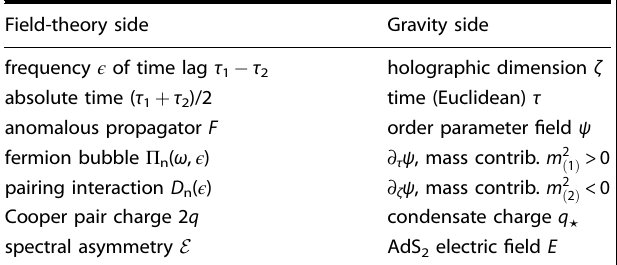
Table 1. Dictionary of the Eliashberg-gravity map. Summary of the correspondence between the degrees of freedom of the critical Eliashberg-SYK theory and those of (1 + 1)-dimensional holographic superconductor. Notice ζ and τ are related to 1/ ϵ and the absolute time by a Radon